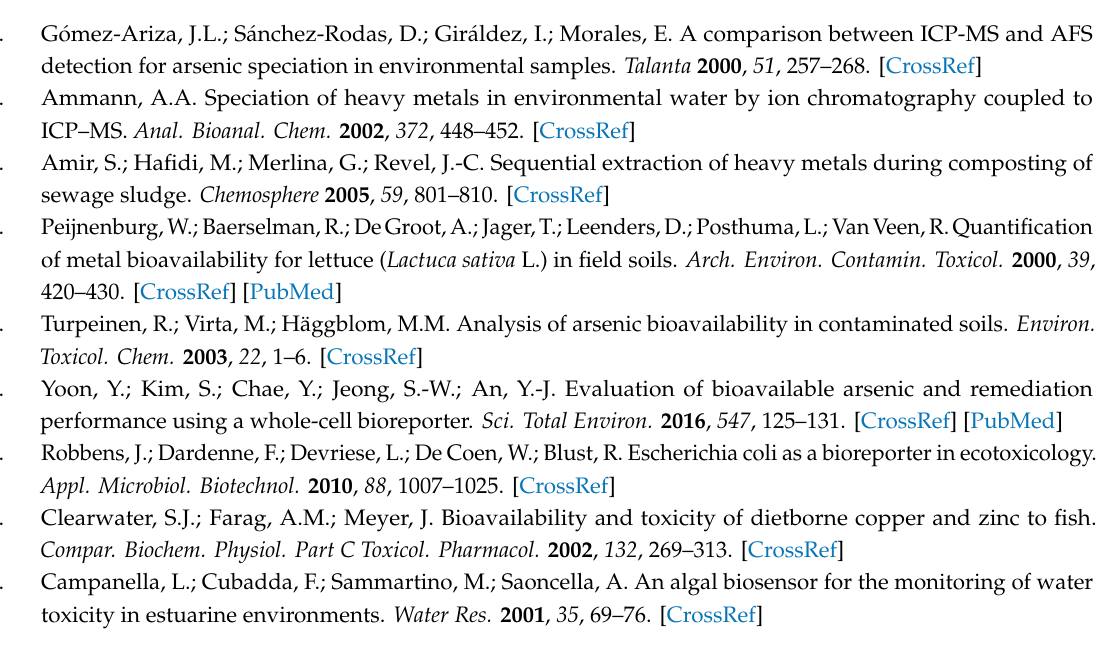
Figure S1: Original fluorescence signals from WCB with eGFP-loop 2 and wild type E. coli with and without eGFP in the presence of cadmium ions. eGFP-loop 2 showed signal with cadmium ion, while basal level signal that was similar level to E. coli without eGFP was determined without cadmium ion. E. coli cells with eGFP as reporter showed much strong